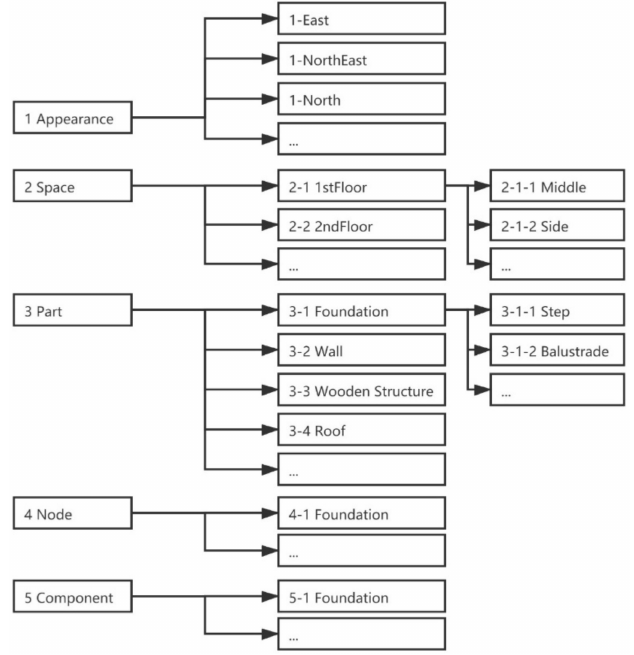
Figure 7. The classified directory of photos.